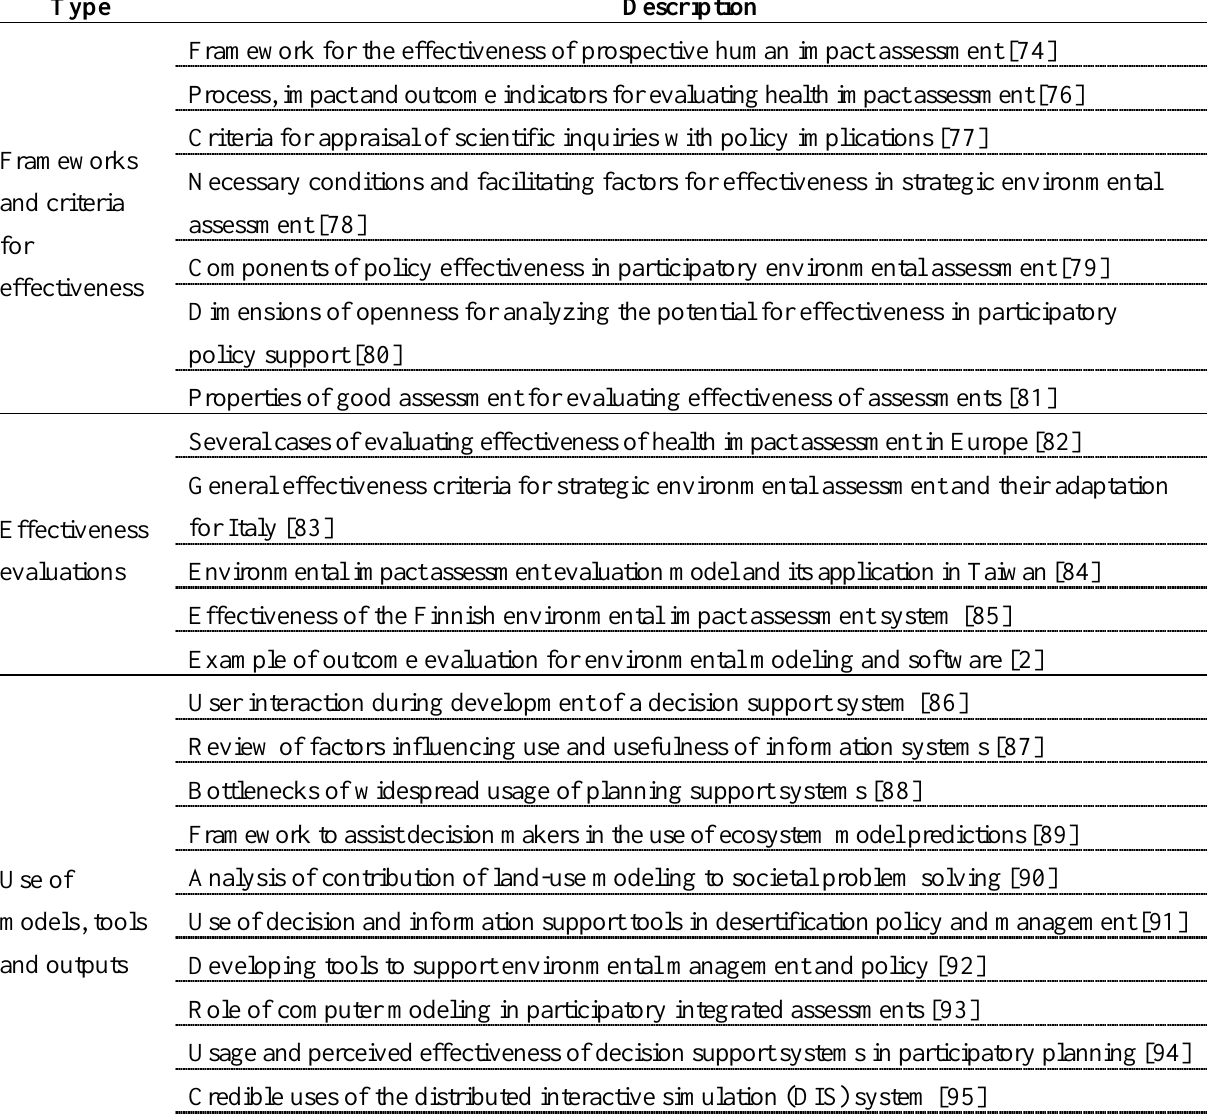
Table 4. Examples of effectiveness perspective to assessment and model